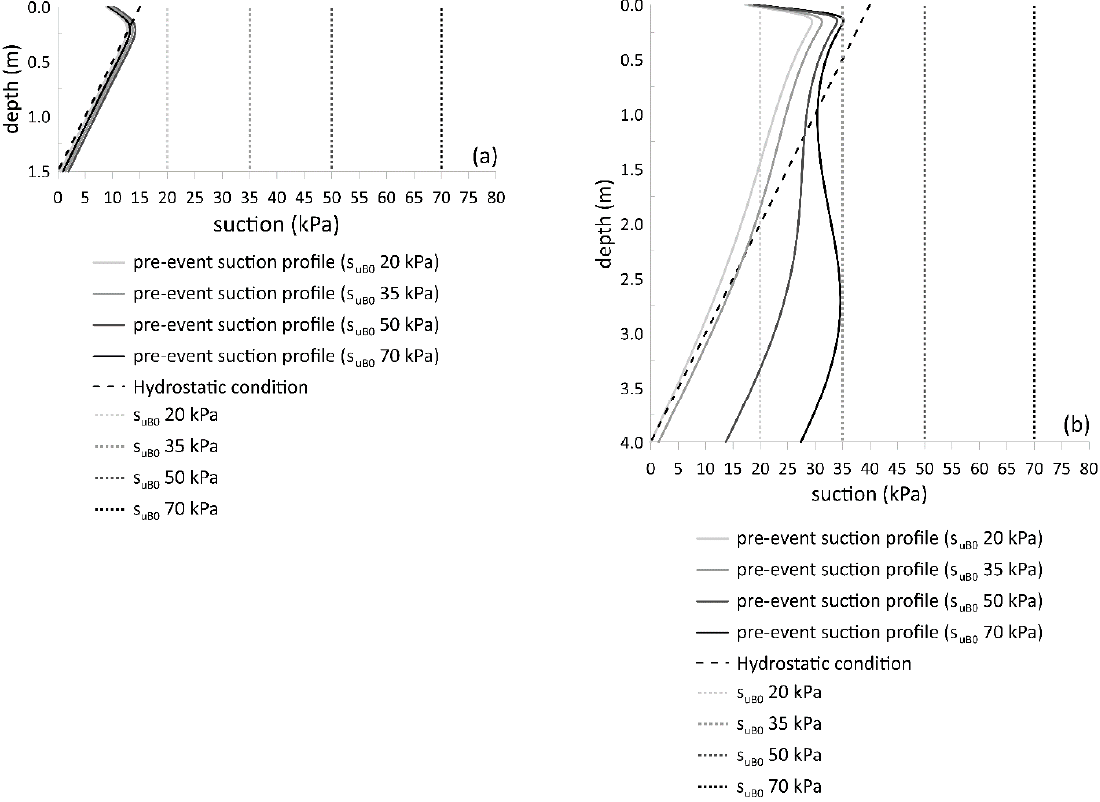
Figure 8. Results of set B analyses: suction distributions computed for four different initial suction values: ( a ) domain s 1.5 = 1.5 m; ( b ) domain s 4 = 4 m.